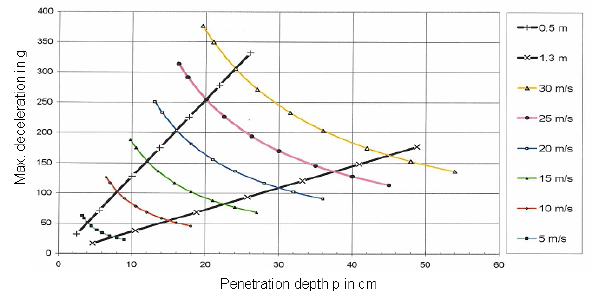
Fig. 10. Penetration and deceleration of impacting rocks onto con- solidated soil of thickness 0.5 m and 1.3 m for different impact ve- locities.